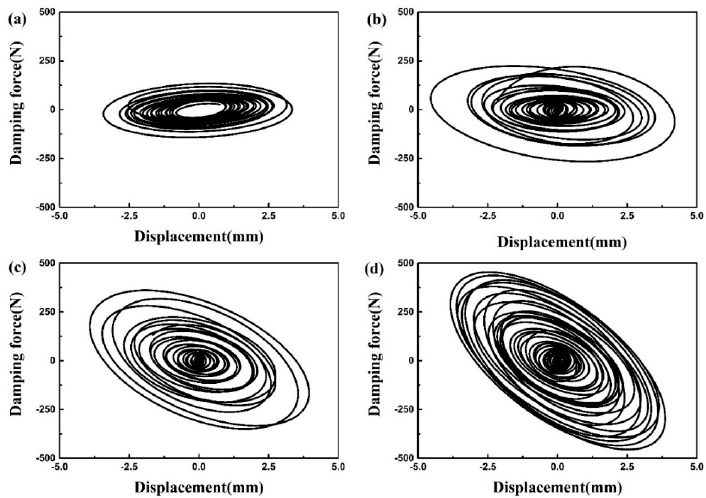
Figure 15. Hysteretic loops of the self-powered MR damper for different modes of the cable. ( a ) First mode; ( b ) Second mode; ( c ) Third mode; and ( d ) Fourth mode.